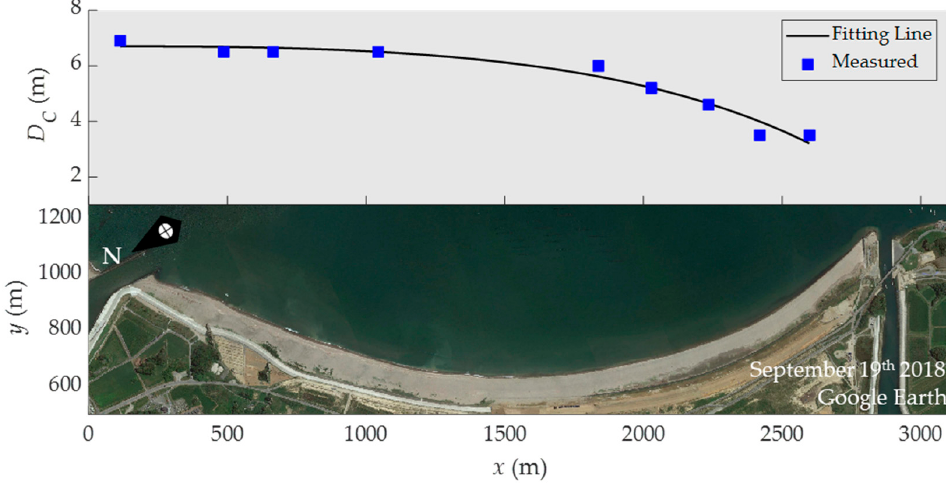
Figure 10. Depth of closure variation.